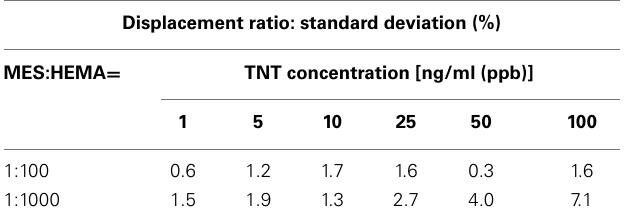
Table 3 | Standard deviation data of the displacement ratio